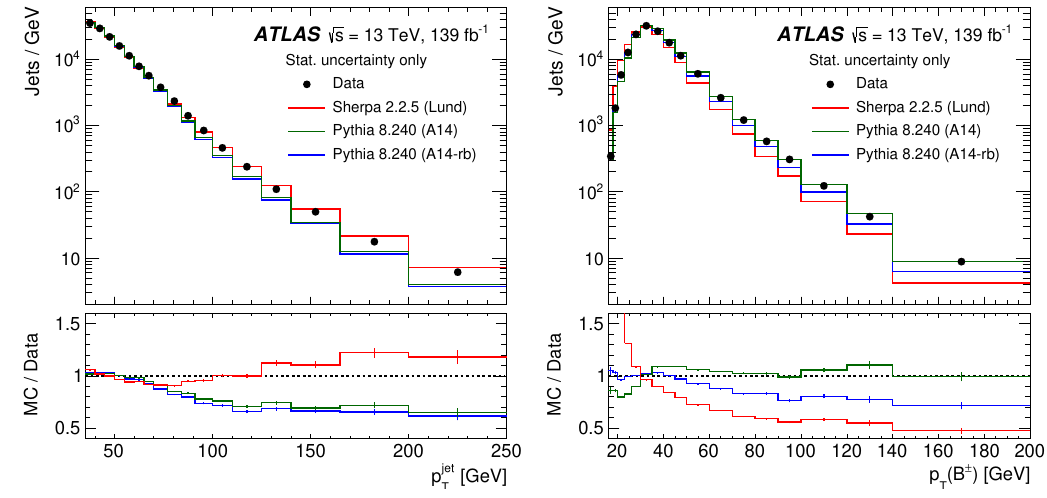
Figure 1 . Distributions of the p T of the selected jets and the B ± meson candidates within them, corrected for purity effects, together with MC predictions. The vertical error bars show the statis- tical uncertainties